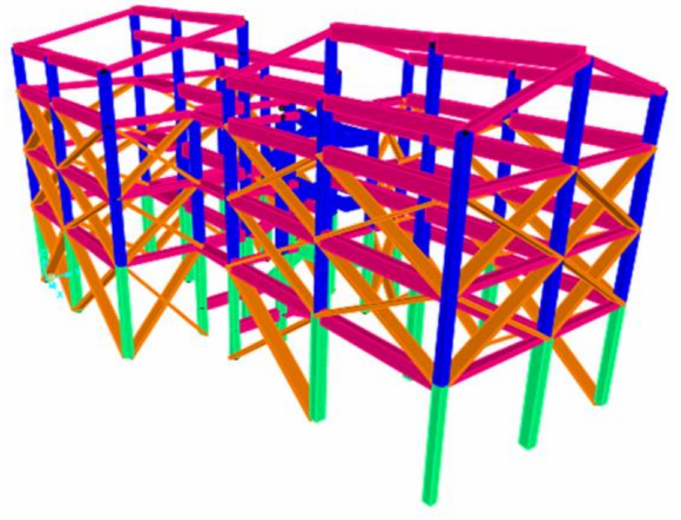
Figure 5. A 3D model of the building under study (current state).